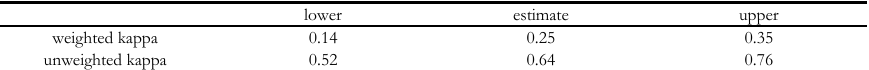
Cohen Kappa and Weighted Kappa correlation coeffcients and confidence boundaries of METAVIR vs TE